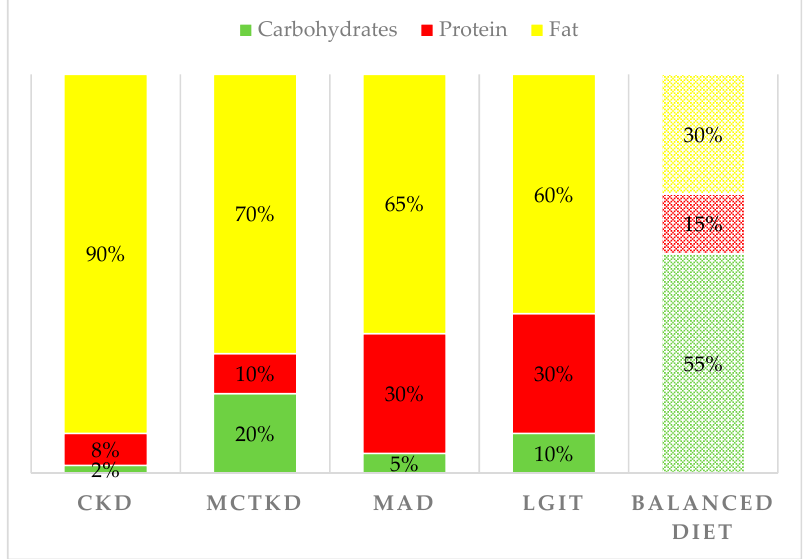
Figure 1. Proportion of calories provided by fat, protein, and carbohydrates in the different variants of KD compared to a typical balanced diet.